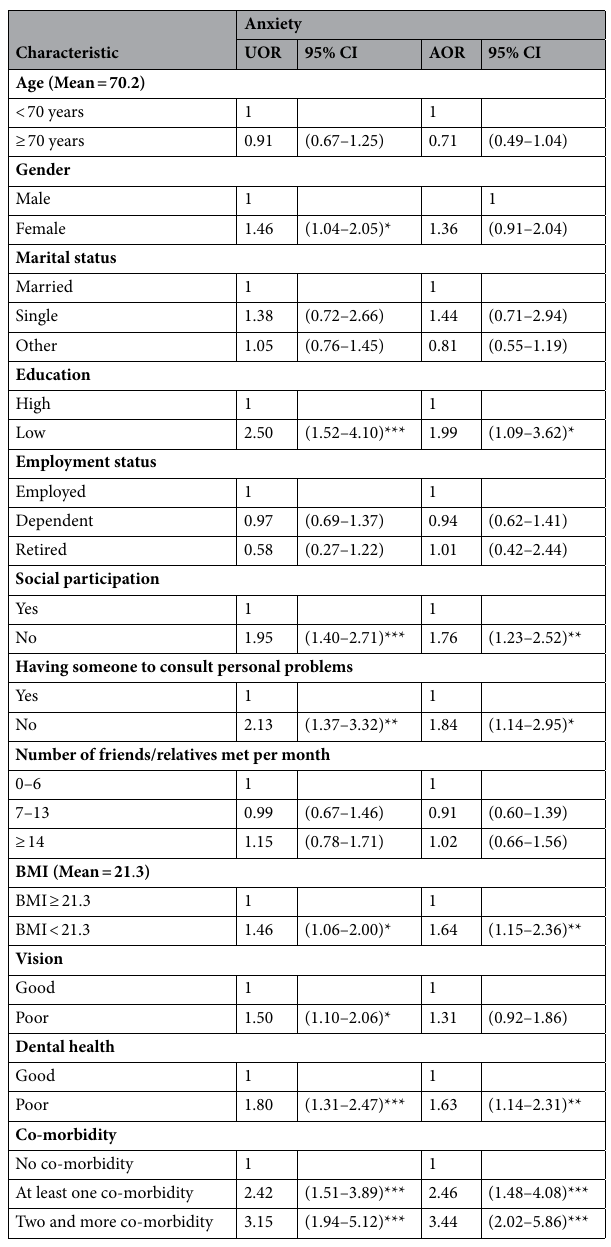
Table 3. Multiple logistic regression of anxiety and associated factors among the study participants (N = 655). AOR Adjusted for age, gender, marital status, education, employment status, social participation, having someone to consult personal problems, number of friends/relatives met per month, body mass index, vision, dental health, co-morbidity; UOR unadjusted odd ratios, BMI Body Mass Index. *p < 0.05, **p <